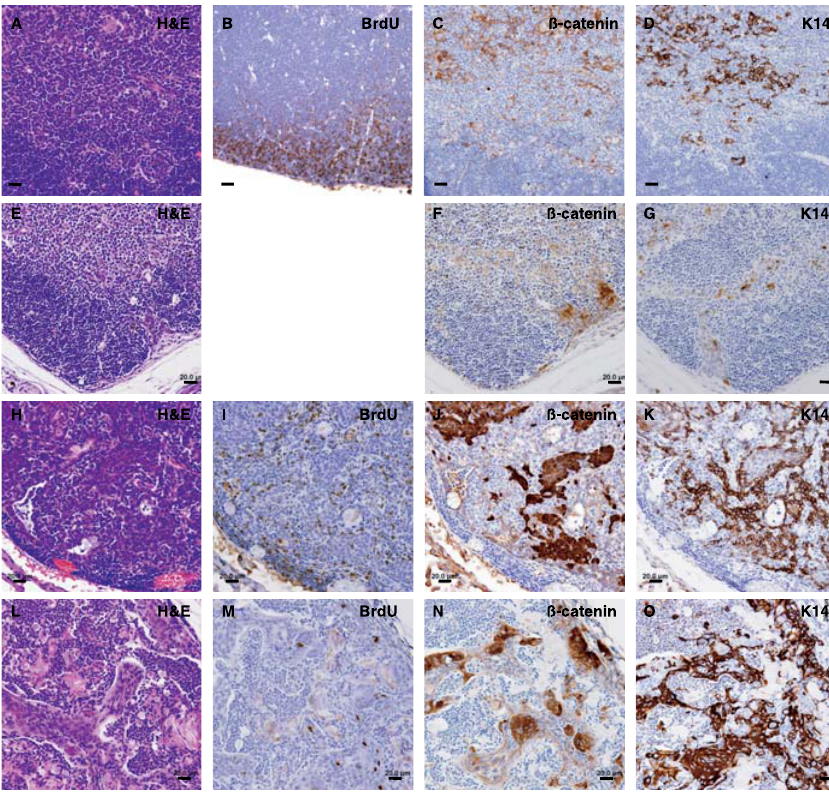
Figure 6. Histological and Immunochemical Examination of Thymus (A–D) P3 normal thymus. (E–G) Mild P3 mutant thymus. (H–K) Severe P3 mutant thymus. (L–O) P13 mutant thymus. Stained with H&E for histology (A, E, H, L), BrdU (B, I, M), b -catenin (C, F, J, N), and K14 (D, G, K, O). (B) Actively dividing thymocytes are visible at the superficial edge of cortex of normal P3 thymus. Note the progression of histological abnormalities in the mutant thymus from mild P3, severe P3 to P13 (A, E, H, L). Scale bars, 20 l m. DOI: 10.1371/journal.pgen.0020146.g006